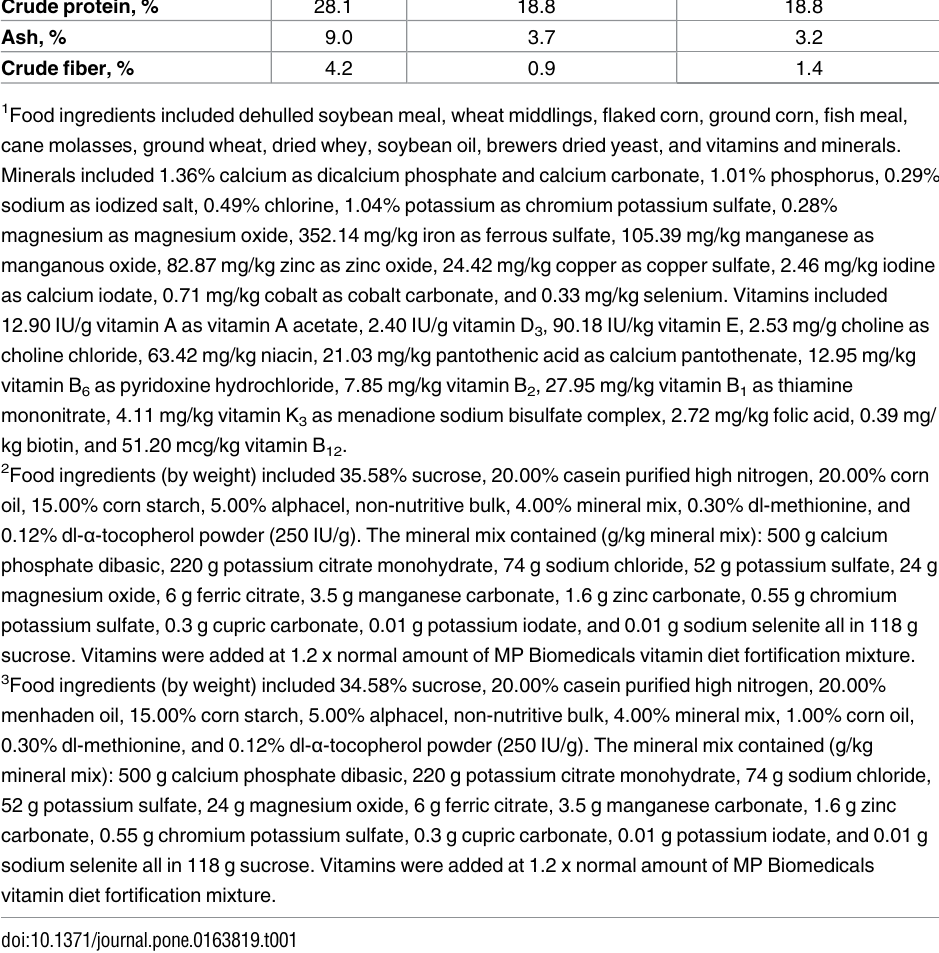
paring retention times of authentic standards (Nuchek Prep, Elysian, MN). Peak areas and per- centages were calculated using Hewlett Packard ChemStation software (Agilent Technologies Inc, Wilmington, DE). The FA data are reported as weight % of total FA (g/100g FA). Bronchoalveolar lavage fluid cytology The trachea was exposed and cannulated with an intravenous catheter (Surflo i.v. catheter, 18 g x 6.4 cm; Butler Animal Health Supply, Visalia, CA). The lungs were manually lavaged with 0.5 mL phosphate buffered saline (PBS) three times. For each lavage, the fluid was washed in and out twice before collection. The recovered BAL fluid was collected and 200 uL removed for dif- ferential cell counts of macrophages, neutrophils, eosinophils, and lymphocytes from cytospin preparations of cells stained with Wright Giemsa. Two hundred cells were counted on each slide. Results are expressed as percentages of total cell count.